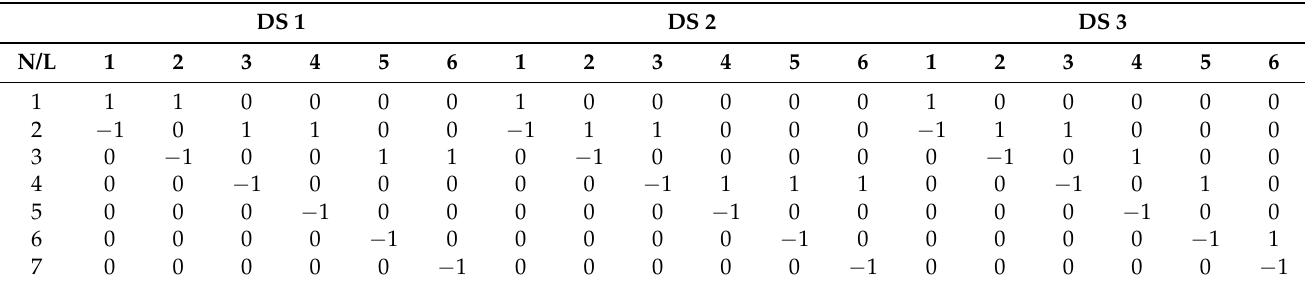
Table A11. Table representing the incidence matrix of the network in different DSs a n , l